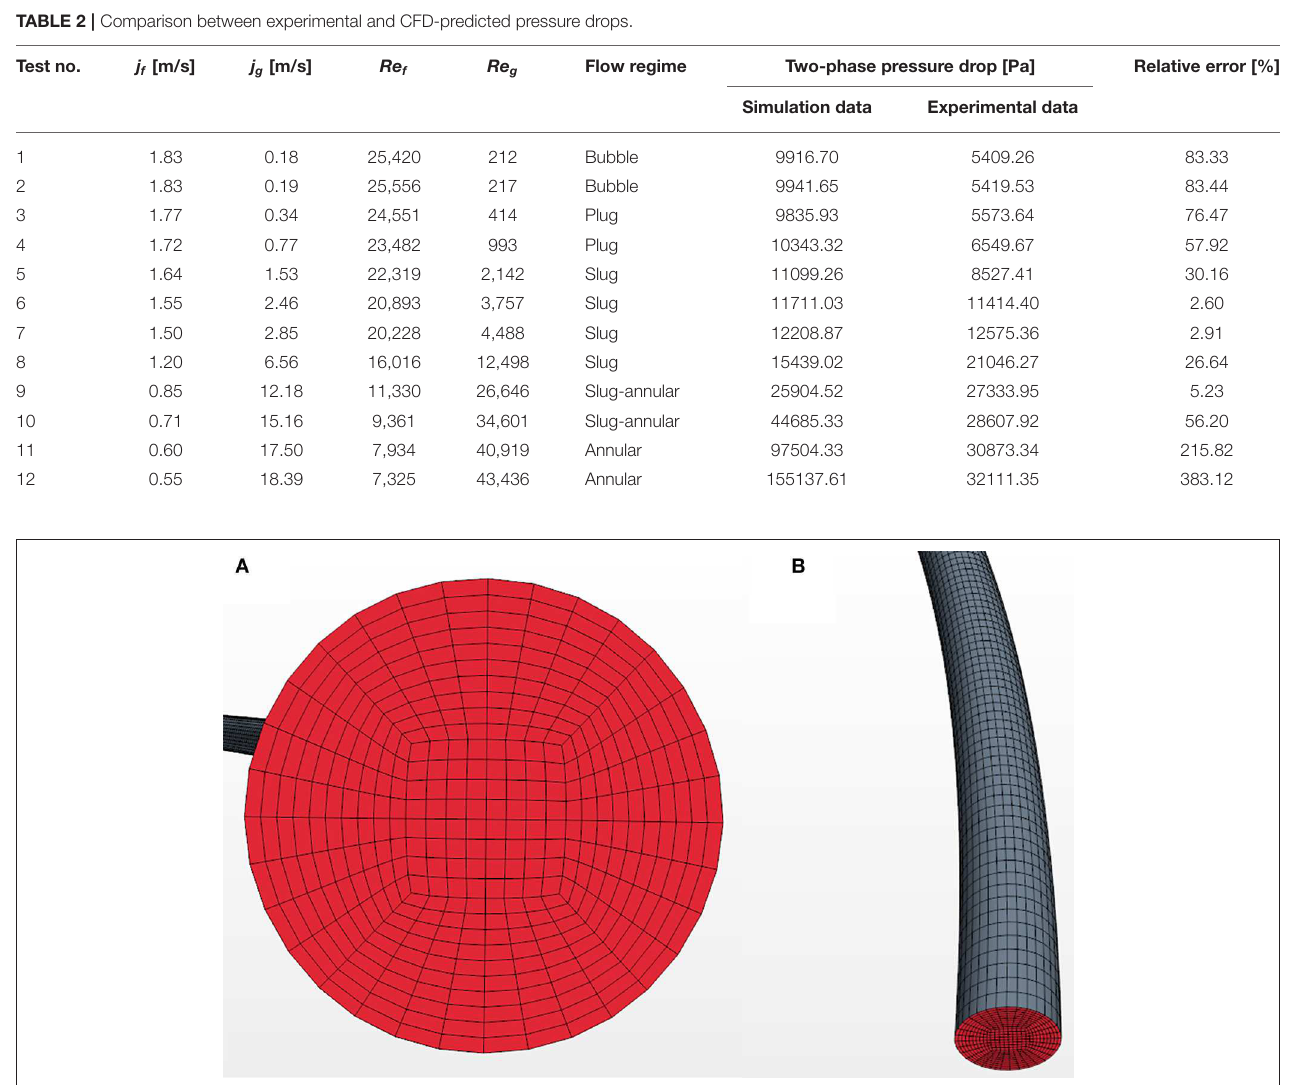
FIGURE 2 | O-grid mesh (A) on the initial cross section and (B) in axial direction.